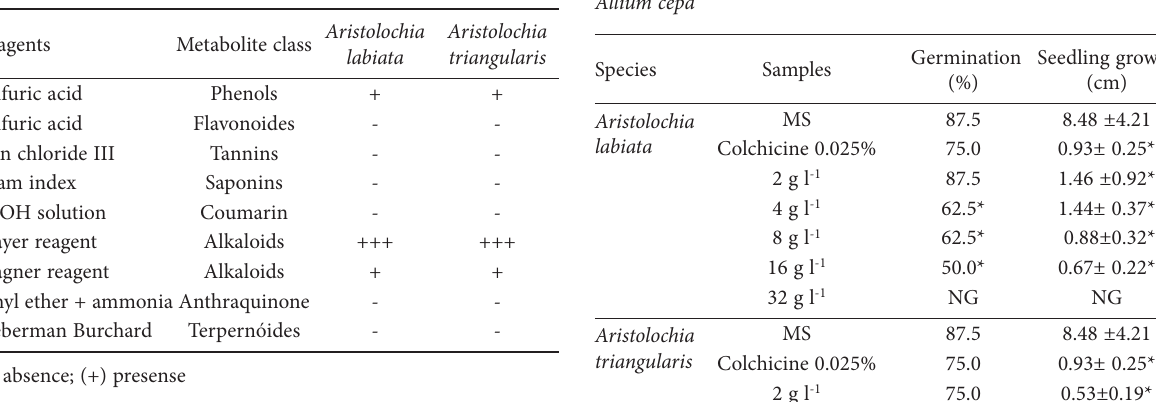
Table 2. Effects of decoctions of to Aristolochia labiata and Aris- tolochia triangularis on seed germination and seedling growth of